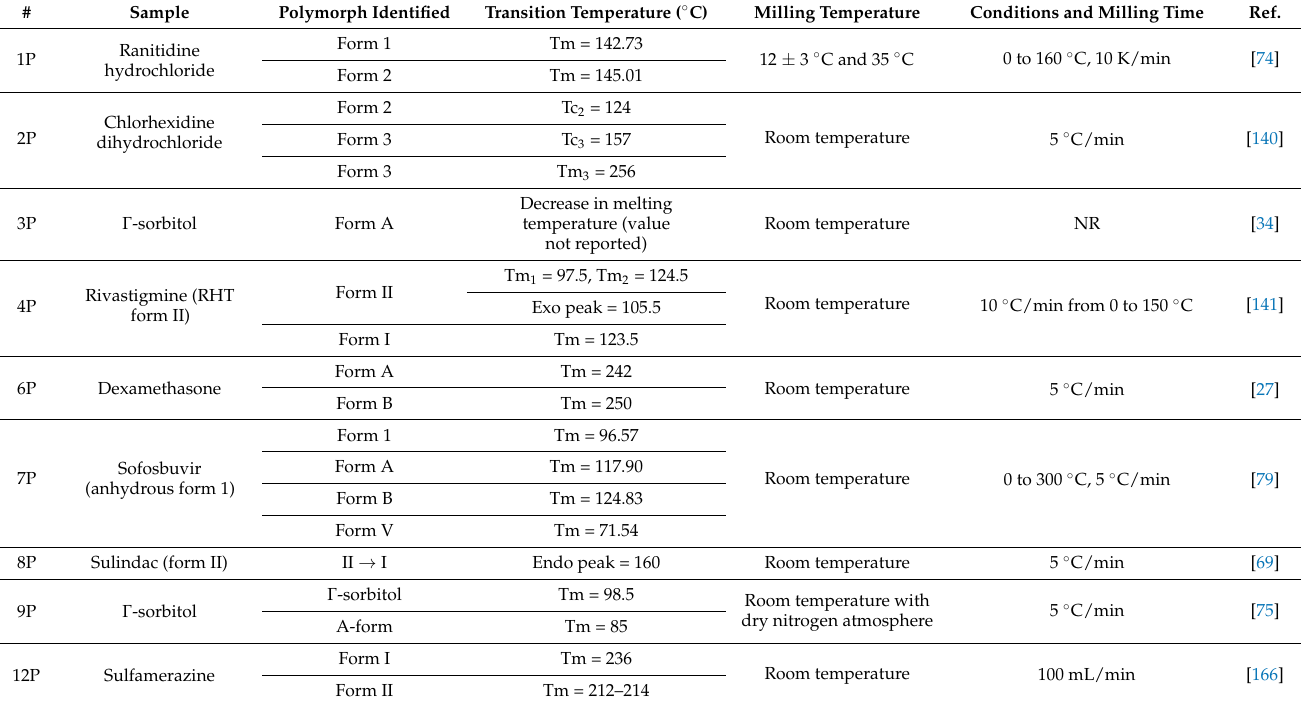
Table 11. Overview of thermal characterization (DSC) of drug polymorphs obtained by ball